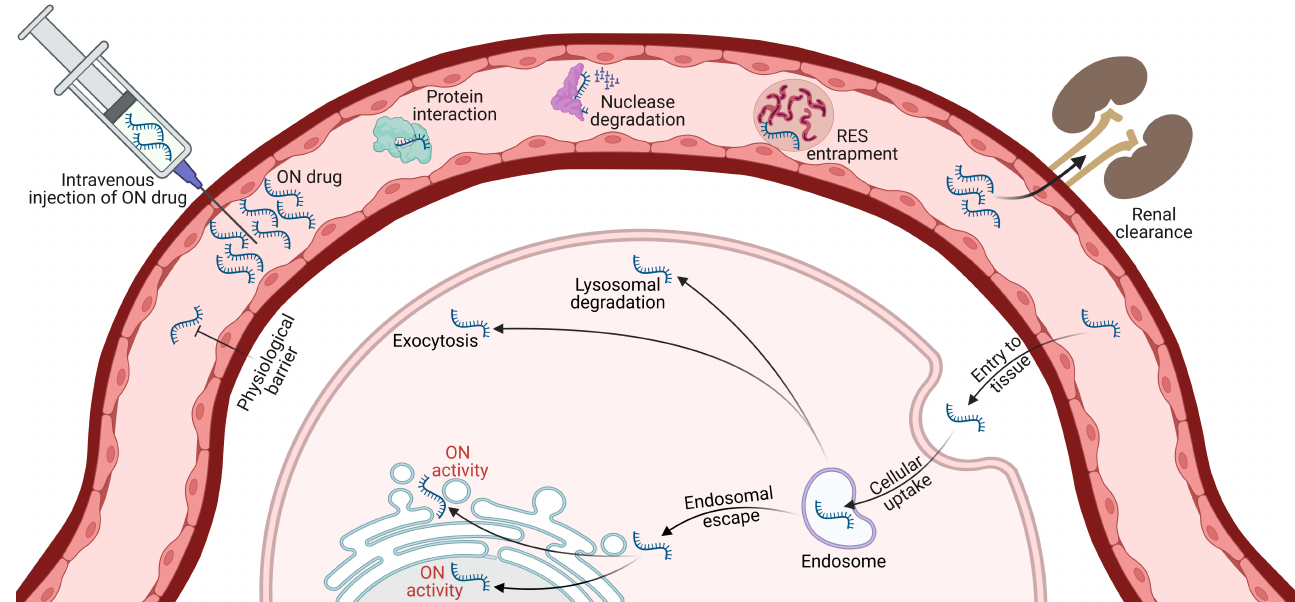
Figure 4. This is a wide figure. Figure 3. Challenges of systemic delivery of ON drugs. Most systemically administered naked ON drugs do not reach the intended tissue/cells. A small drug fraction evades nuclease degradation, RES phagocyte uptake, and renal excretion. Physiological barriers, e.g., the BBB, impede ON drugs from reaching their target. Once reaching the target tissue/cell, it is typically internalized through gymnosis. Following cellular uptake, ON drug molecules require endosomal entrapment escape to reach the target genetic material. Only a minute fraction of the originally administered ON drug effectively reaches its final target and exhibits its activity (Created with BioRender: GP257207MX). Alternative routes, e.g., SC, IP, intrathecal, oral, or topical, also face significant chal- lenges [13]. While they may offer advantages, such as reduced systemic exposure and